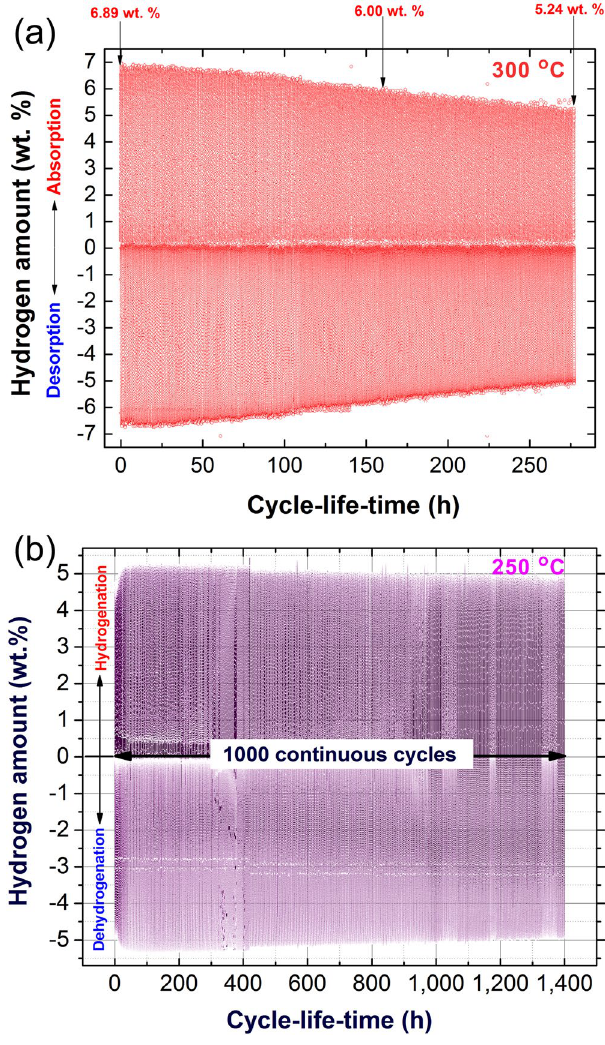
Figure 7. Effect of TiMn 2 additive on the cyclability of MgH 2 powders. Cycle-life-time conducted at 300 °C for ( a ) nanocrystalline MgH 2 powders, and at 250 °C for ( b ) nanocomposite MgH 2 /5 wt.% TiMn 2